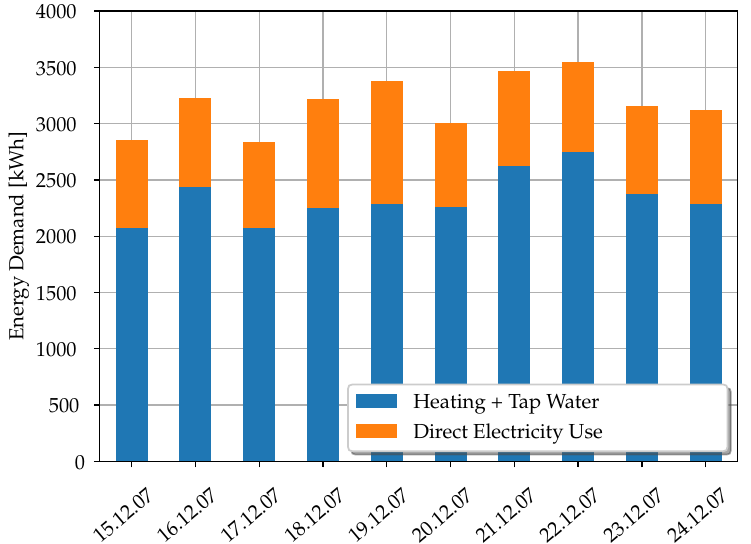
Figure 3. Energy demand analysis on the individual days of the period under consideration. The blue bars show the electrical energy used by the heat pump for hot water and heating in kWh. The orange bars show the other electrical energy used in kWh. A maximum of 3543kWh of energy is required on 22 December 2007. Since a period in which no renewable power is available is assumed for the period under consideration, no power is generated by the buildings’ PV systems and all power is drawn from the